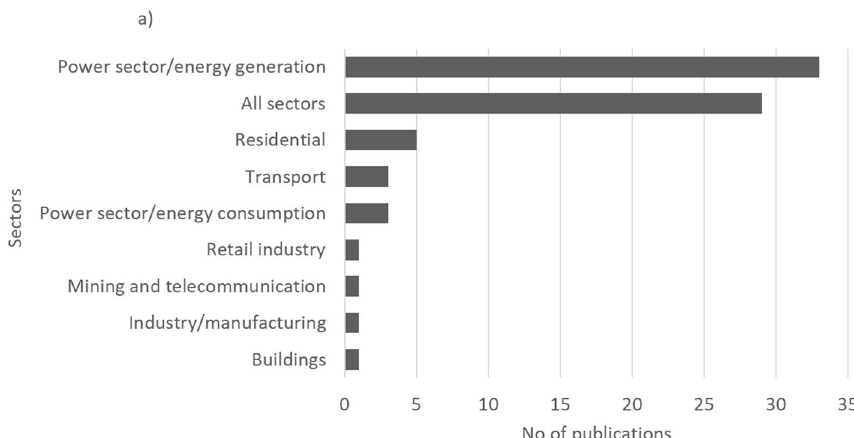
Fig. 4 Regional focus of publi- cations. Source: Authors